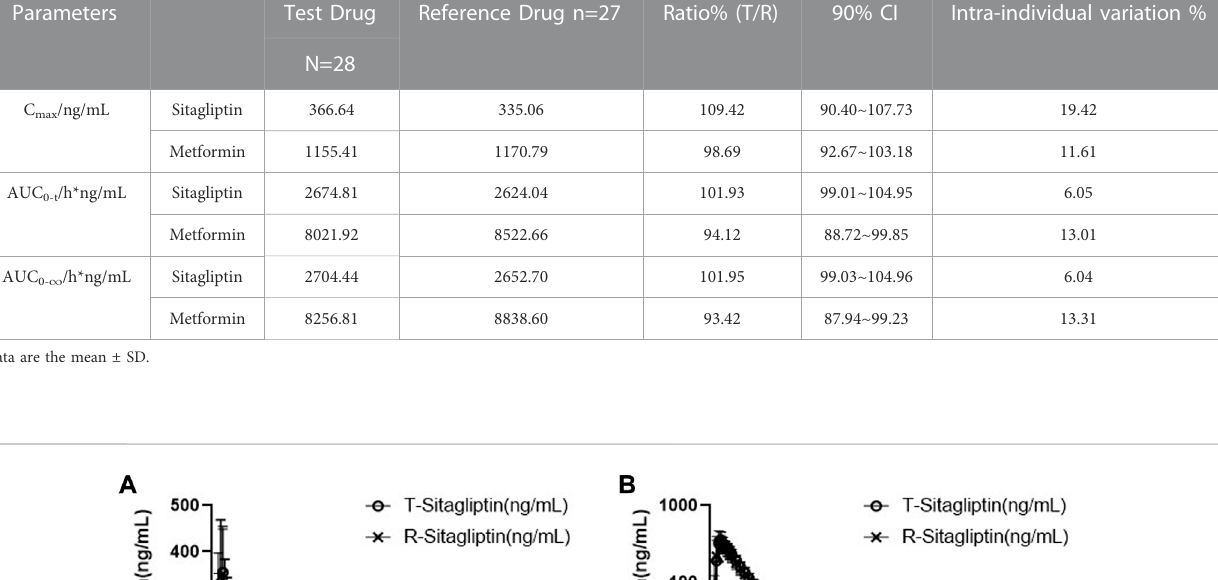
TABLE 3 Statistical comparison of Sitagliptin and Metformin Pharmacokinetic parameters under fasting state. Parameters